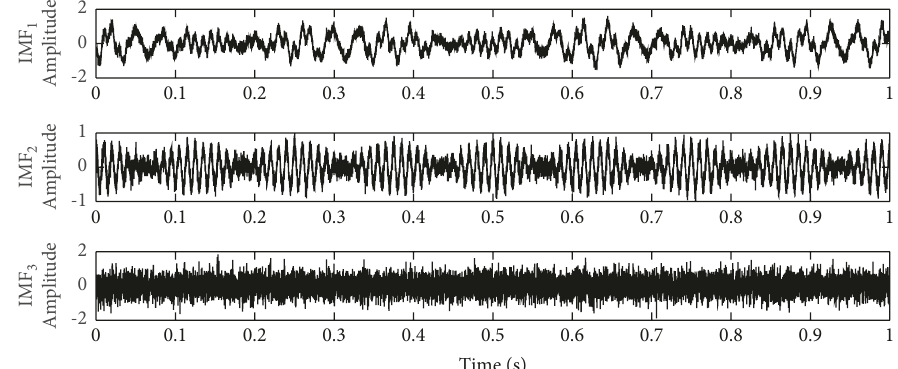
Figure 5: The decomposition result of x ( t ) generated by VMD.